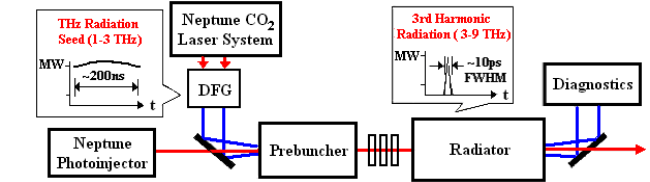
FIG. 10. (Color) Schematic of the high-gain harmonic genera- tion